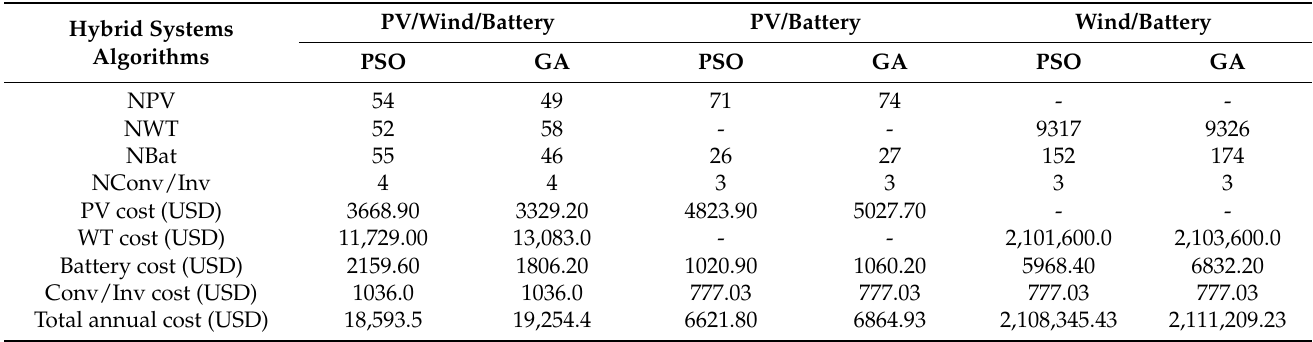
Table 6. Results of optimal sizing for Niger.